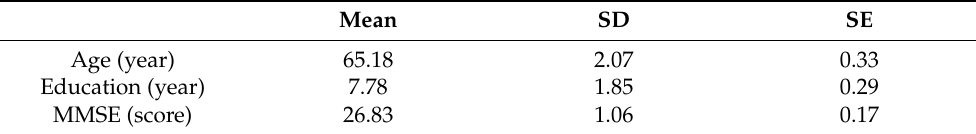
Table 2. Characteristics of the participants in the training of Cleverbrain serious game .